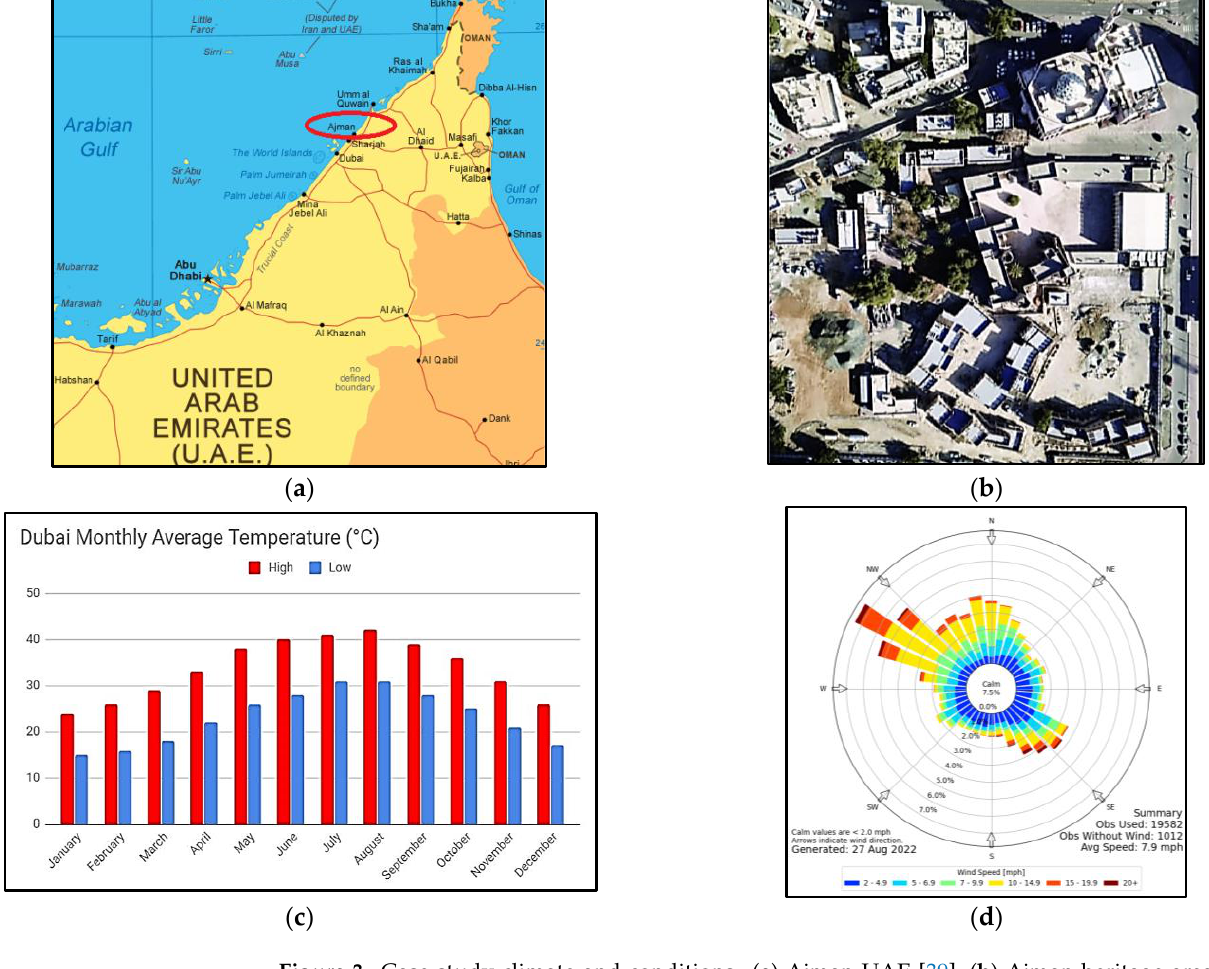
Figure 3. Case study climate and conditions. ( a ) Ajman-UAE [39], ( b ) Ajman heritage area [40], ( c ) Average air temperature [41], ( d ) Wind rose [42].